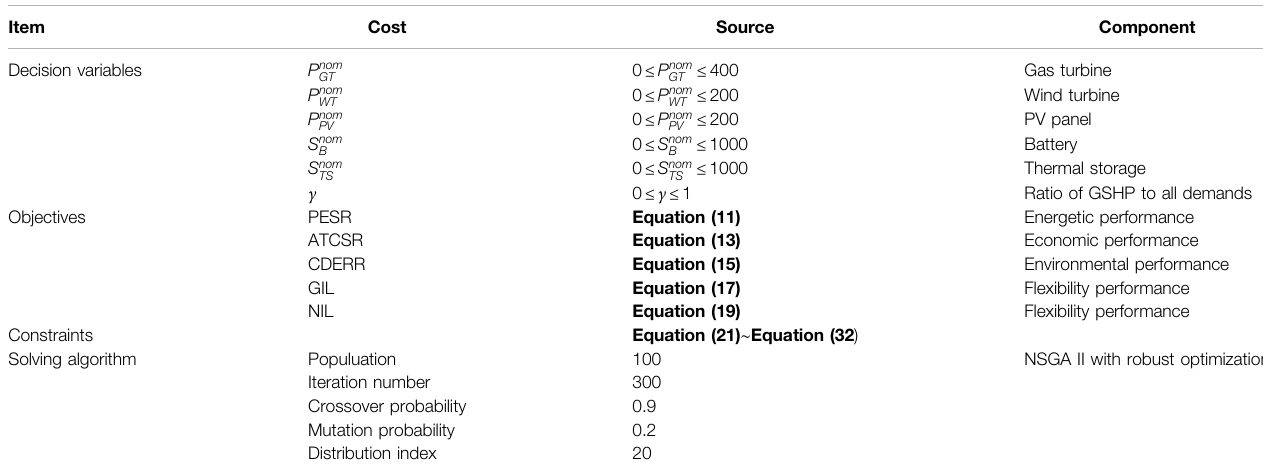
TABLE 4 | The optimization model for the micro-grid